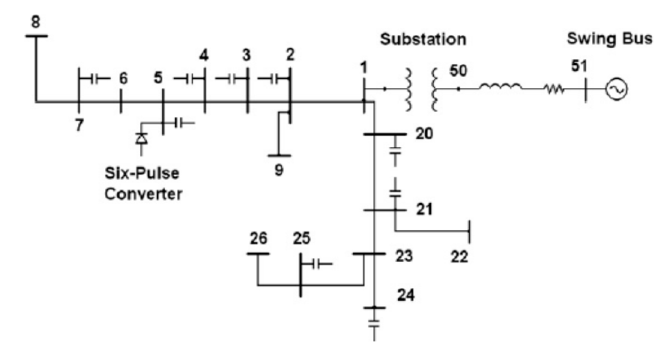
Figure 10. IEEE 18-bus network [21,36]. Figure A1. IEEE 18-bus network [21,36]. The grid line information of the IEEE standard 18-bus network is shown in Table